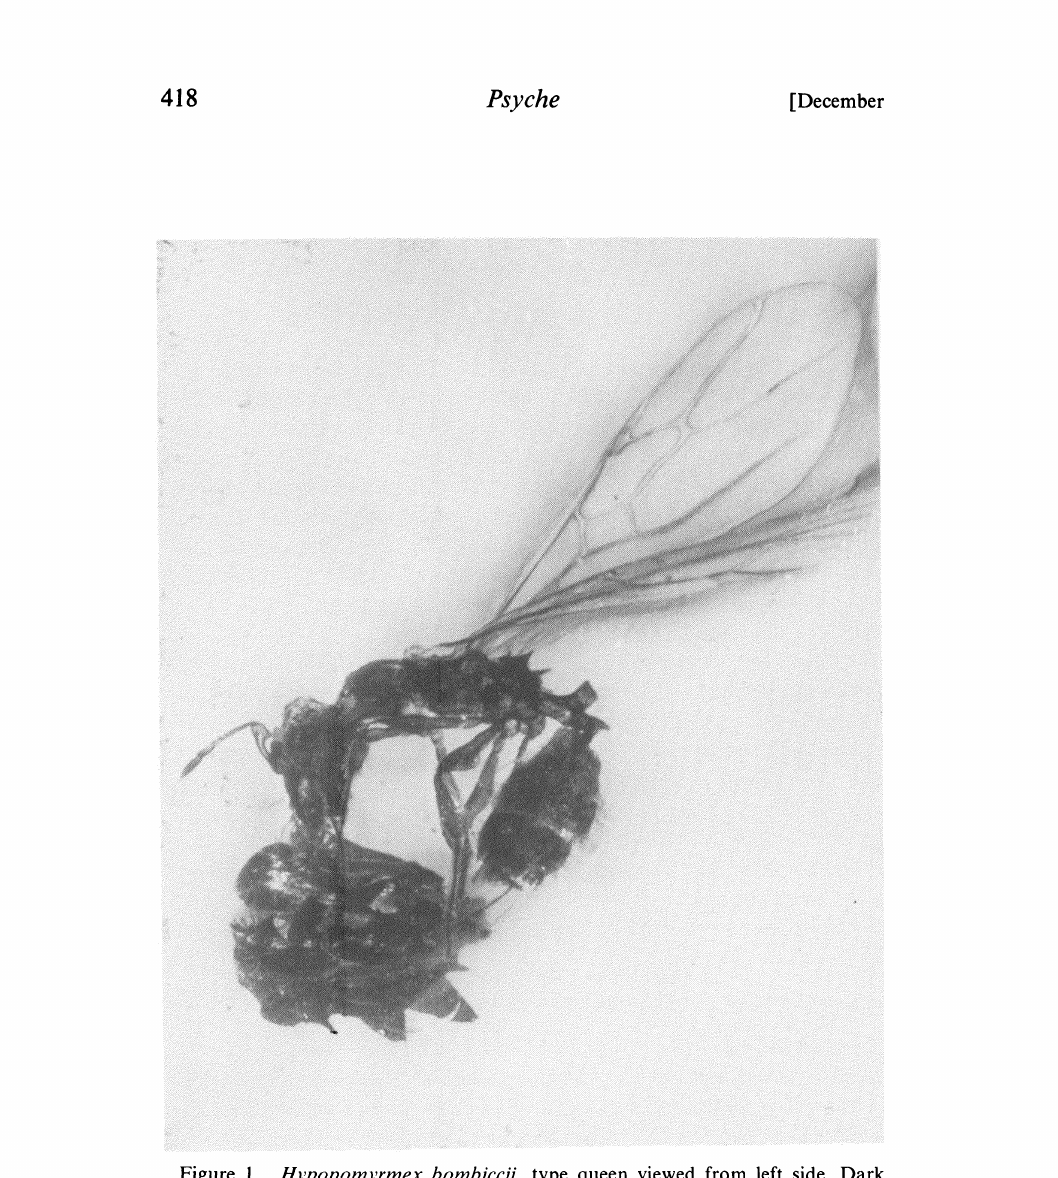
Figure 1. Hypopomyrmex bombiccii, type queen viewed from left side. Dark mass below queen is the curled type of Cataulacus planiceps. The view is essentially the same as portrayed by Emery (1891" pl. 1, fig. 10). Length of fore wing, 3.7